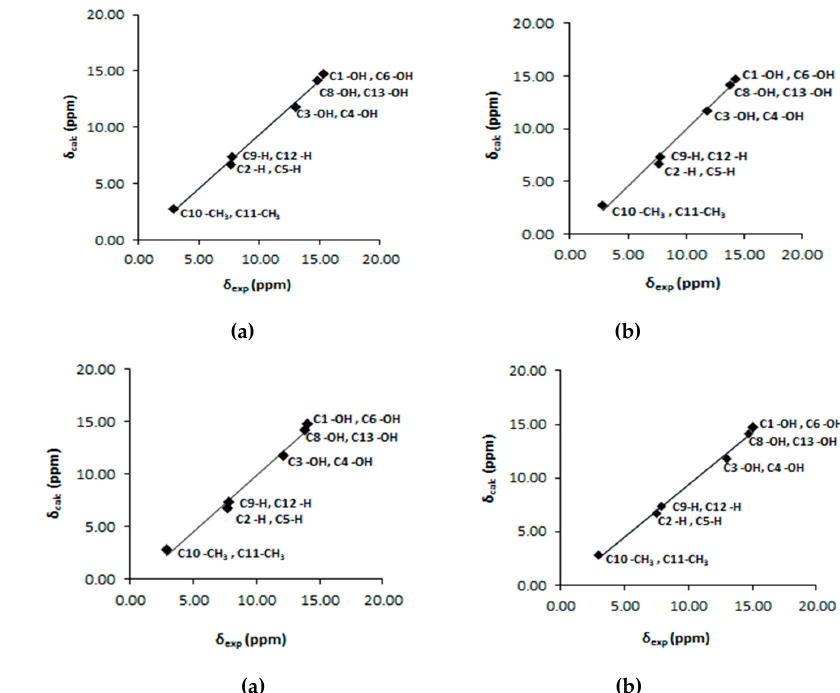
Figure 19. ( A ) Calculated ( δ calc , ppm) (at the GIAO B3LYP/6-311+G(2d,p) level of theory) vs. experimental values ( δ exp , ppm) of the 1 H-NMR chemical shifts of neutral hypericin + 1 molecule of acetone with minimization of the structures at the B3LYP/6-31+G(d) (CPCM) ( a ) and at the TPSSh/TZVP (CPCM) ( b ), level of theory, respectively; ( B ) Calculated ( δ calc , ppm) (at the GIAO B3LYP/6-311+G(2d,p) level of theory) vs. experimental values ( δ exp , ppm) of the 1 H-NMR chemical shifts of neutral hypericin + 2 molecules of acetone with minimization of the structures at the B3LYP/6-31+G(d) (CPCM) ( a ) and at the TPSSh/TZVP (CPCM) ( b ) level of theory, respectively. Reprinted, with permission, from [50]. Copyright 2016, by Elsevier Science Ltd